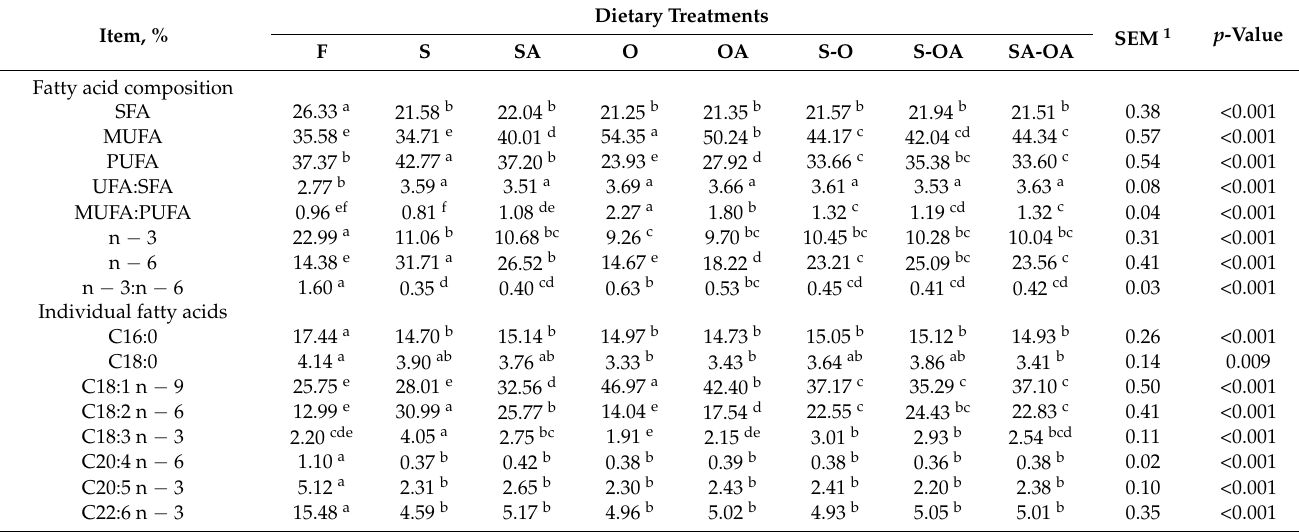
Table 8. Fatty acid composition of perivisceral fat from European seabass according to different dietary fat